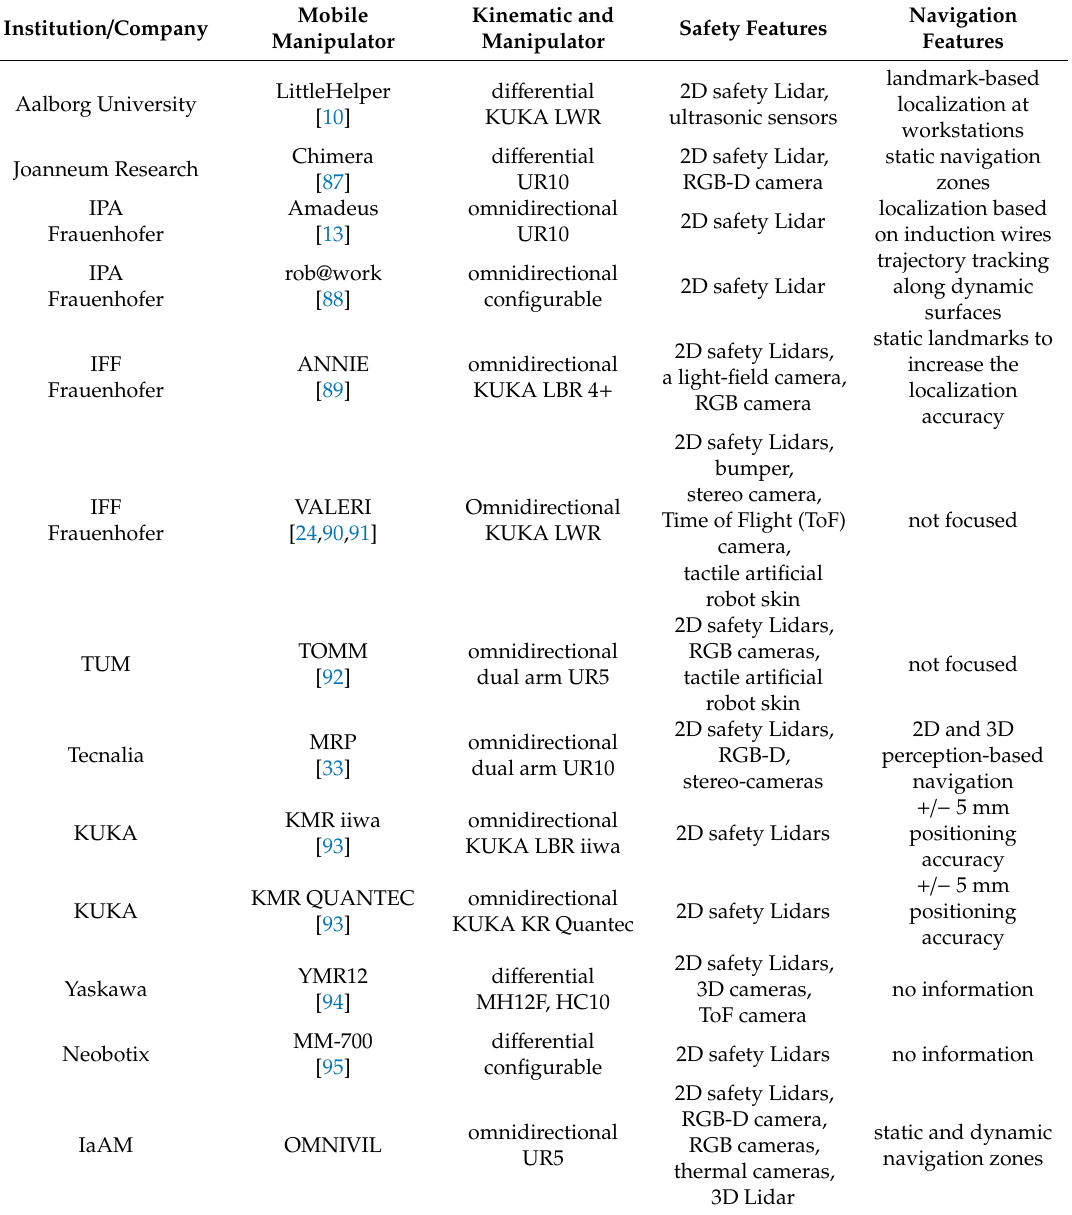
Table 6. Overview of related mobile manipulators developed in research and